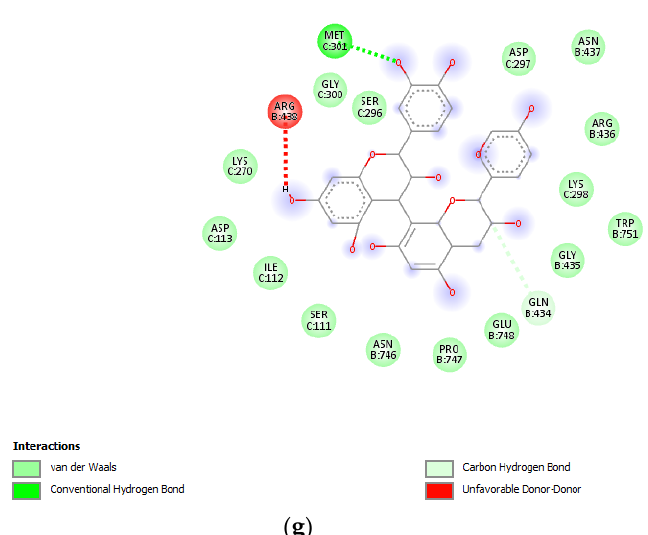
Figure 10. ( a ) Putative interactions between apigenin and E. coli gyrase (PDB: 6RKS). Free energy of binding ( ∆ G) and a ffi nity (Ki) are − 7.3 kcal / mol and 4.5 µ M, respectively. ( b ) Putative interactions between quercetin and E. coli gyrase (PDB: 6RKS). Free energy of binding ( ∆ G) and a ffi nity (Ki) are − 7.2 kcal / mol and 5.4 µ M, respectively. ( c ) Putative interactions between isovitexin and E. coli gyrase (PDB: 6RKS). Free energy of binding ( ∆ G) and a ffi nity (Ki) are − 8.4 kcal / mol and 0.7 µ M, respectively. ( d ) Putative interactions between vitexin and E. coli gyrase (PDB: 6RKS). Free energy of binding ( ∆ G) and a ffi nity (Ki) are − 8.5 kcal / mol and 0.6 µ M, respectively. ( e ) Putative interactions between luteolin and E. coli gyrase (PDB: 6RKS). Free energy of binding ( ∆ G) and a ffi nity (Ki) are − 7.7 kcal / mol and 2.3 µ M, respectively. ( f ) Putative interactions between methoxy-trihydroxy(iso)flavone and E. coli gyrase (PDB: 6RKS). Free energy of binding ( ∆ G) and a ffi nity (Ki) are − 6.9 kcal / mol and 8.9 µ M, respectively. (g) Putative interactions between procyanidin B and E. coli gyrase (PDB: 6RKS). Free energy of binding ( ∆ G) and a ffi nity (Ki) are − 8.0 kcal / mol and 1.4 µ M, respectively.